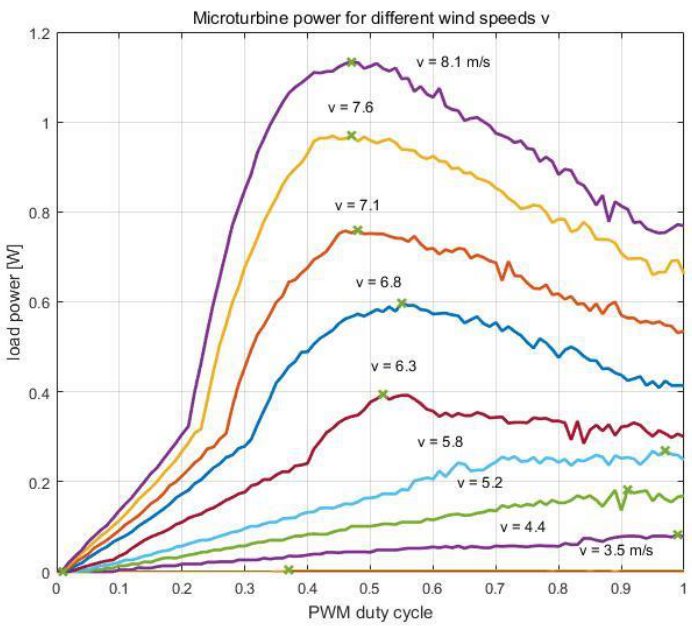
Figure 14. The power generated by a wind turbine with a constant pitch, as a function of the control value — duty cycle of the PWM signal, for different wind speeds.